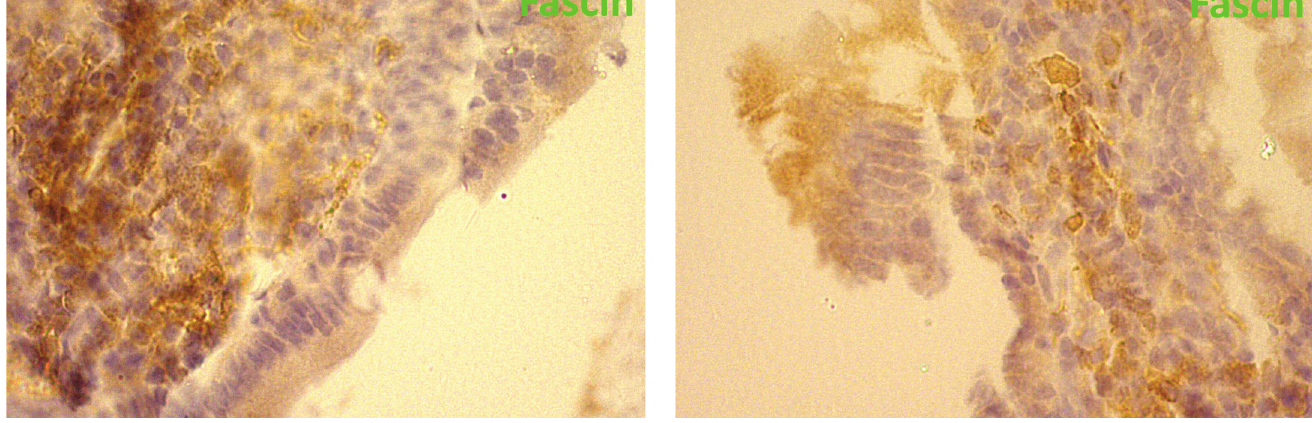
Figure 3 - Fascin immunostaining in the small intestine of an animal administered a common food additive E407a. A higher fascin expression is observed in the lamina propria. Fragments of desquamated epithelia with strong fascin expression are seen in the lumen. 400x.